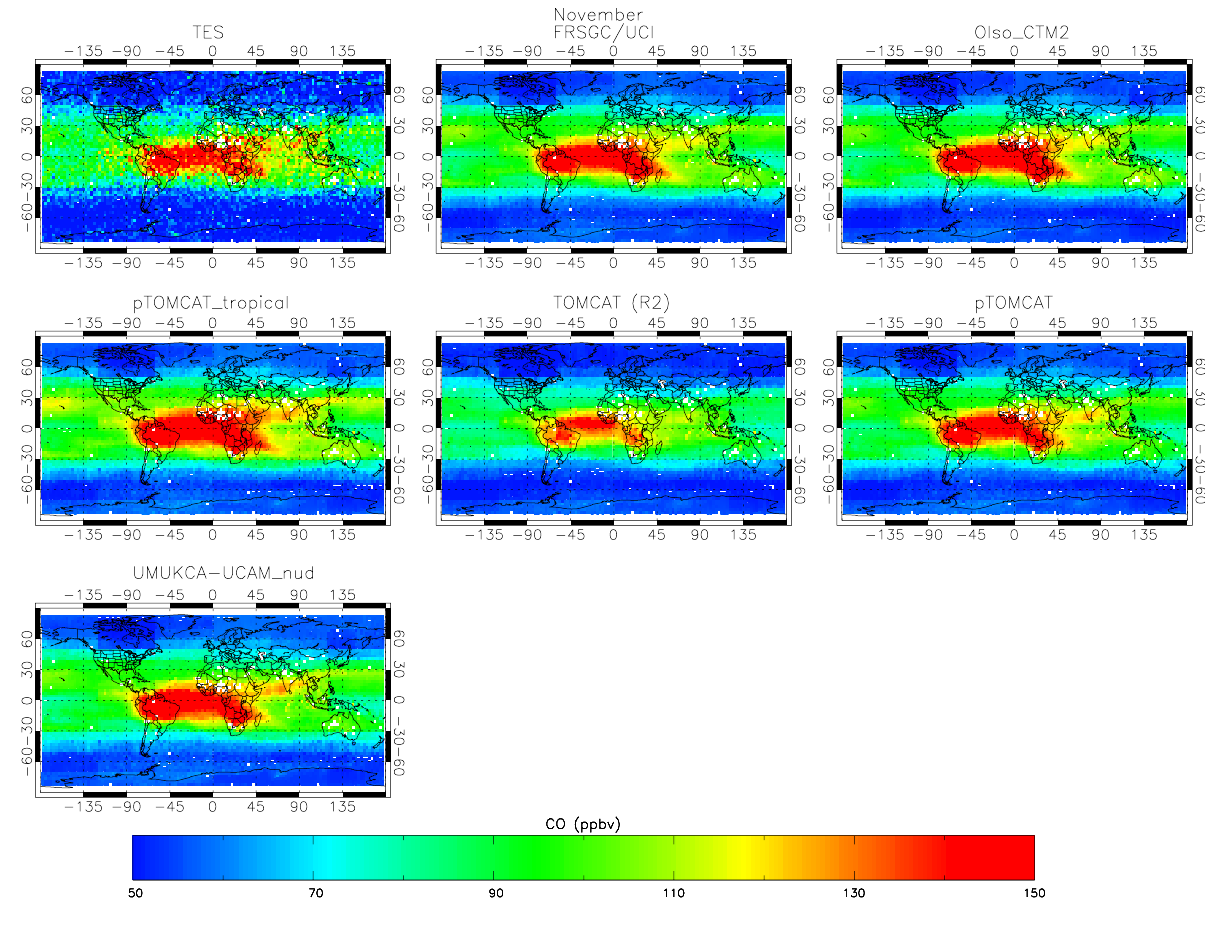
Fig. 16. As in Fig. 11, but for 195hPa and November